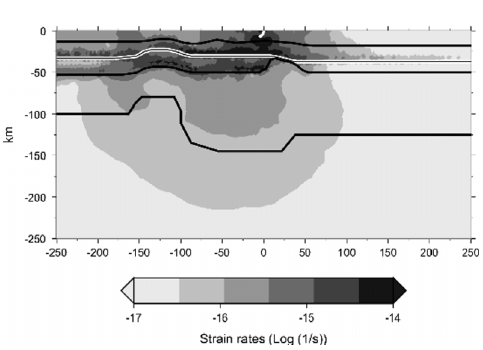
Fig. 3. 2D section through the Central Apennines, showing postseismic strain rates at 1 year after the earthquake. The Colfiorito Fault (CF) is represented by the small white segment in the center of the do- main, and the Moho by the thin black line bounded in white.